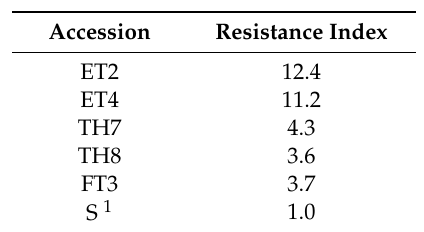
Table 6. Resistance index (RI) of E. colona accessions according to the dose-response experiment. The data is based on GR 50 values calculated from dry weight